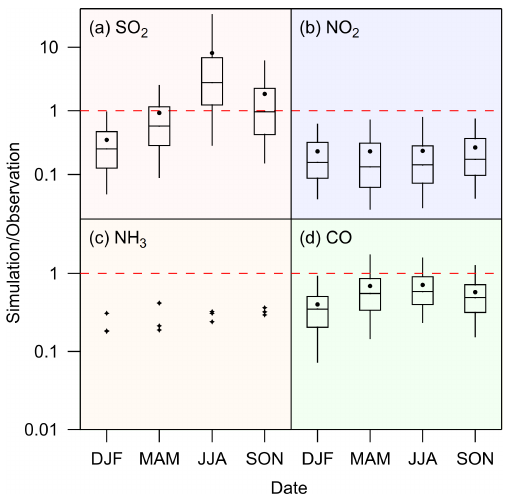
Figure 4. The simulation-to-observation ratios of the concentrations of (a) SO 2 , (b) NO 2 , (c) NH 3 , and (d) CO in Beijing. The upper and lower edges of the boxes, the whiskers, the middle lines, and the solid dots in panels (a) , (b) , and (d) denote the 25th and 75th percentiles, the 5th and 95th percentiles, the median values, and the mean values of the simulation-to-observation ratios of the hourly mean concentrations of the corresponding species at the PKUERS site from July 2011 to May 2013, respectively. The solid dots in (c) represent the simulation-to-observation ratios of the monthly mean concentrations of NH 3 at the IAP site from December 2007 to November 2010. The dashed red lines show the 1:1 simulation- to-observation ratio. Figure 5. Diurnal profiles of the hourly mean simulated and ob-